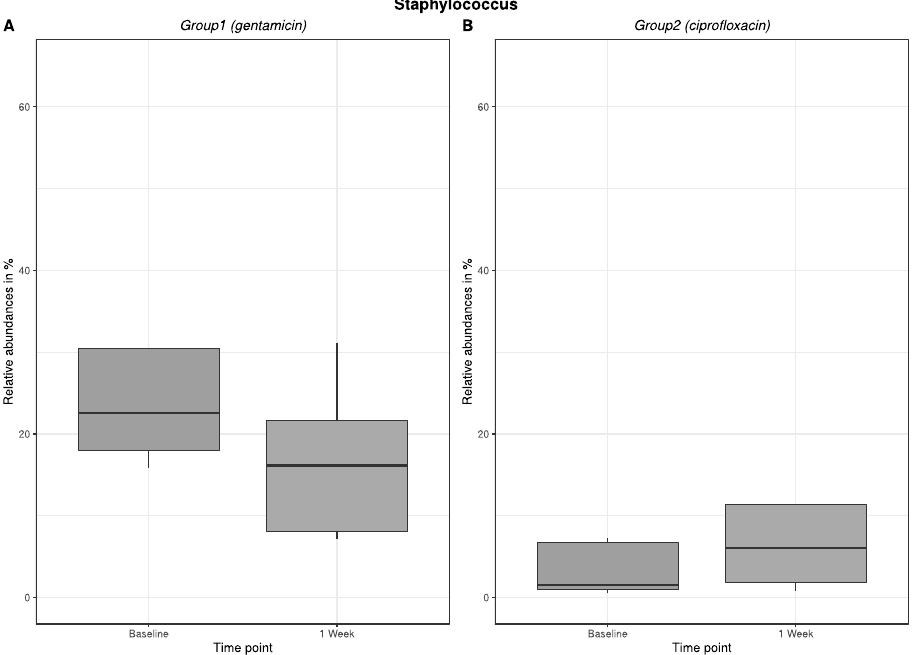
Figure 4. The change in relative abundance in % (Streptococcus/nasal) after 1-week use of gentami- cin or ciprofloxacin eye drops. Figure ( A ) shows the change in relative abundance in % in group 1, which received gentamicin for one week. Figure ( B ) shows the change in relative abundance in % in group 2, which received ciprofloxacin for one week. 4. Discussion In healthy subjects, we discovered that use of antibiotic eye drops for one week had an influence on the nasal microbiome. This is of relevance due to the fact that various illnesses, especially respiratory diseases, including allergic or chronic rhinosinusitis with nasal polyps, asthma, bronchitis, or influenza have been linked to changes in the nasal microbiome [29]. Studies detected correlations between the alteration of the nasal